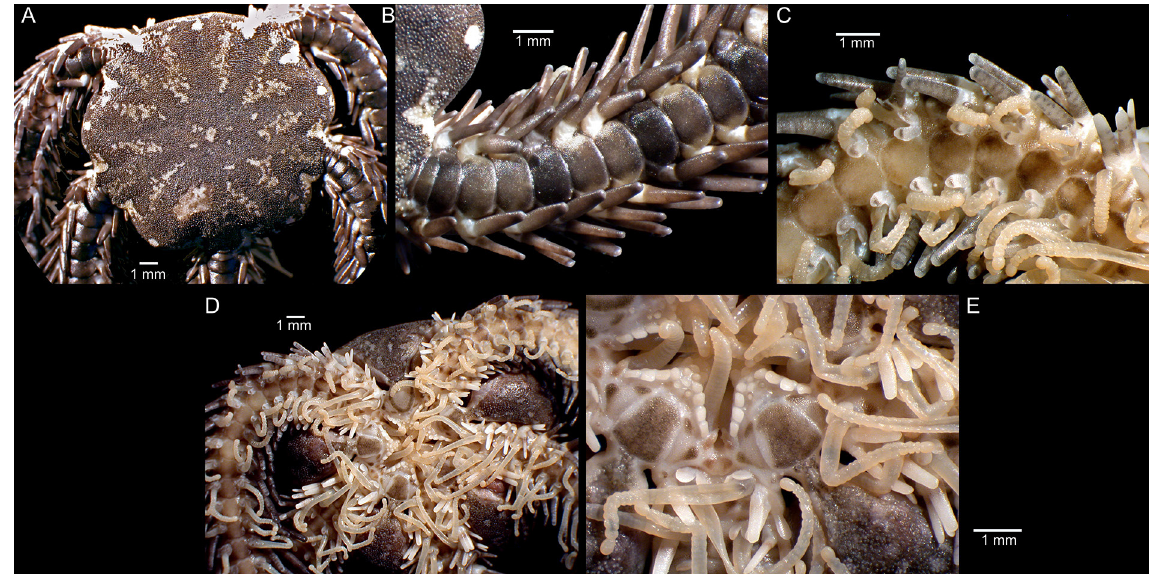
Fig. 6. Holotype of Ophiocoma ( Breviturma subgen. nov.) krohi sp. nov. (MNHN-IE-4300). A . Dorsal disc. B . Dorsal arm. C . Ventral arm, note the pattern on the arm spines. D . Ventral disc. E .